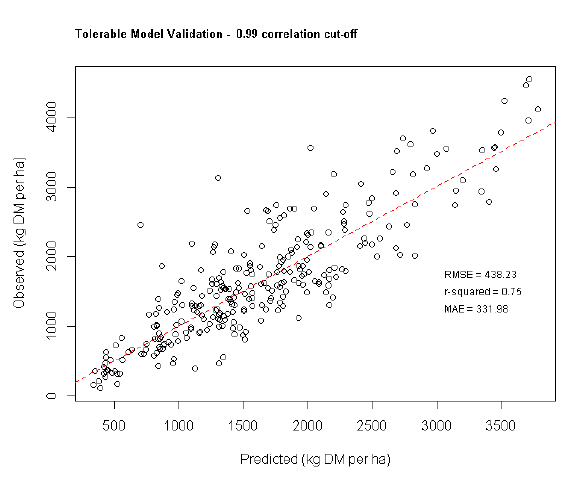
Figure 7 - Model performance (validation). Cut-off = |0.99|